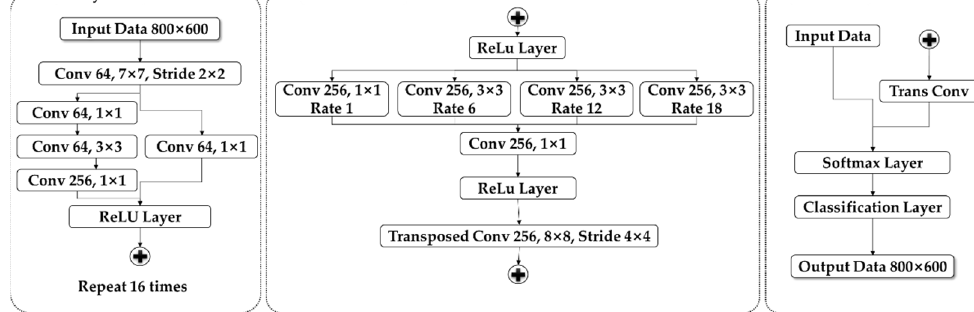
Figure 10. Structure of Deeplab-V3+/ ResNet-50.